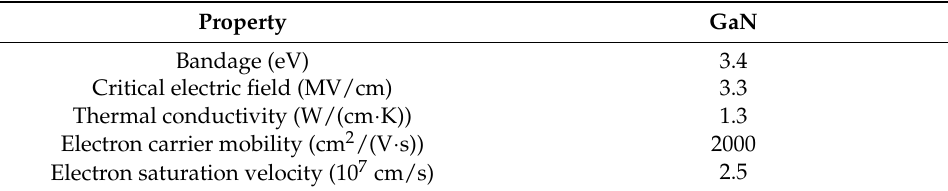
Figure 1. Schematic diagram of AlGaN/GaN HEMT structure. Table 1. The basic material properties of GaN.